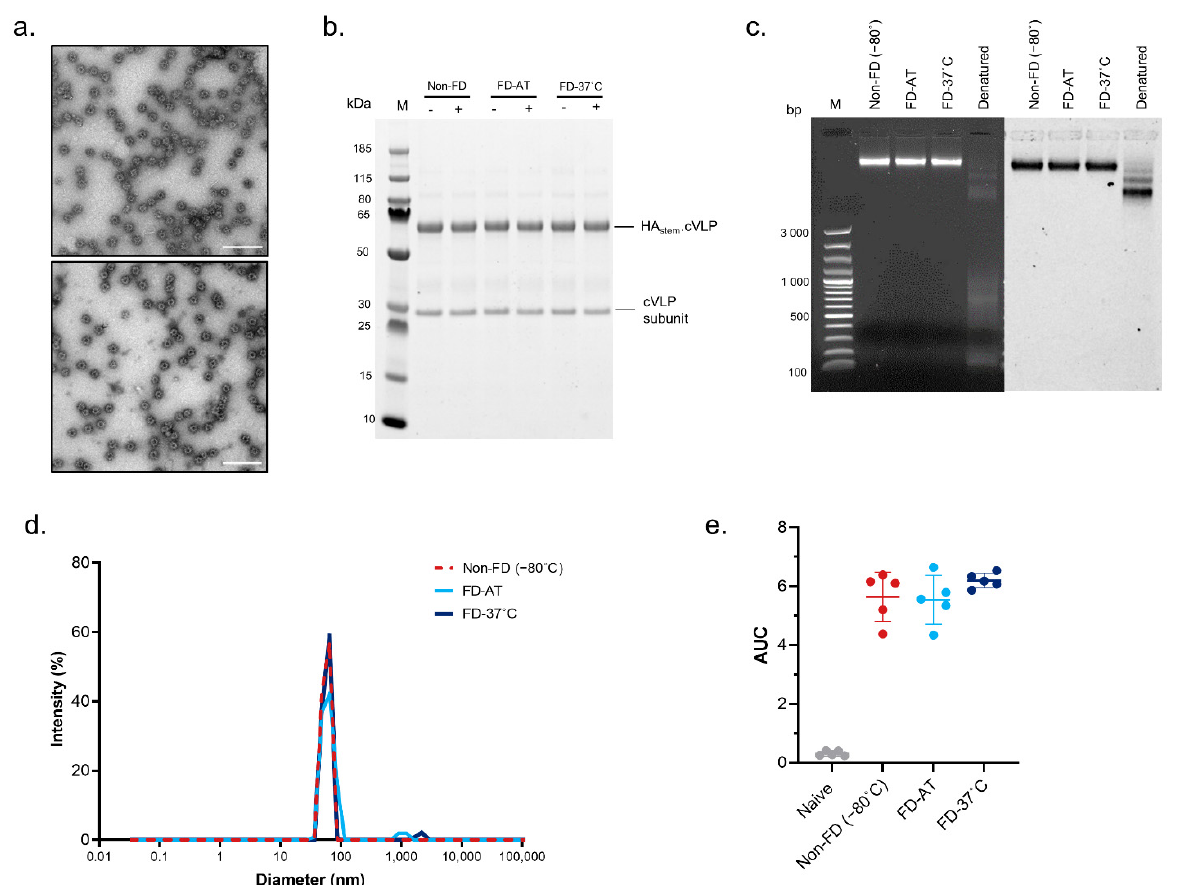
Figure 2. HA stem -cVLP influenza vaccine maintains its stability and immunogenicity after freeze- drying. HA stem -cVLP vaccine was freeze-dried and stored at ambient temperature (FD-AT) or 37 ◦ C (FD-37 ◦ C) for 1 week ( A ) or 2 months ( B – E ). The stability of the reconstituted material was subsequently compared to a frozen, non-freeze-dried (non-FD ( − 80 ◦ C)) reference sample, which had been stored at − 80 ◦ C for the same period. ( A ) Representative transmission electron microscopy (TEM) images of non-freeze-dried HA stem -cVLP reference sample (top panel) and freeze-dried HA stem .cVLP (bottom panel). Scale bar represents 200 nm. ( B ) Representative reduced SDS-PAGE analysis of non-FD and FD HA stem -cVLP samples before (-) and after (+) centrifugation (2 min at 16,000 × g ). ( C ) Agarose gel electrophoresis stained with ethidium bromide (left) and Coomassie brilliant blue (right). Native non-FD and FD samples were run in parallel to a denatured reference sample. ( D ) Overlay of DLS analysis of non-FD and FD HA stem -cVLP. ( E ) Immunogenicity of freeze- dried HA stem -cVLP. Anti-HA stem IgG ELISA titers measured in serum from mice ( n = 5) immunized with either a non-FD or FD HA stem -cVLP vaccine. Results show the mean ± SD area under the curve (AUC)